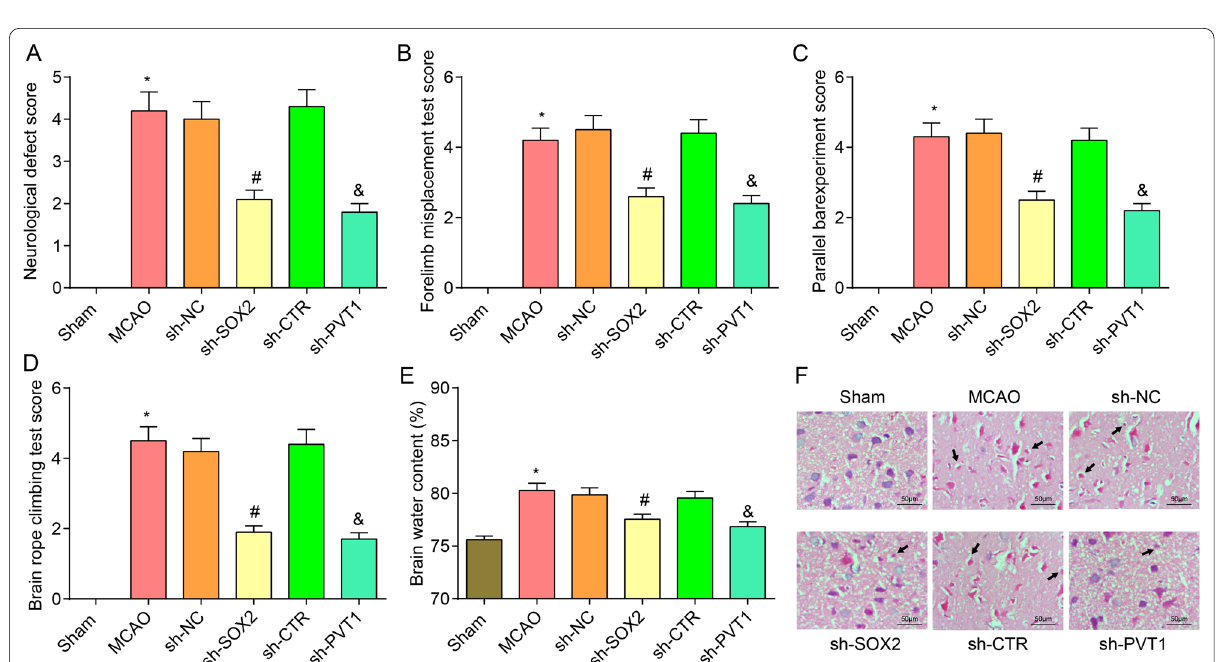
Fig. 3 Depleted SOX2 or PVT1 attenuates neurological deficits, motor behavioral and pathological damage in MCAO rats. A Neurological defect scores of rats in each group after inhibition of SOX2 or PVT1 (n 8 rats per group); B Forelimb foot fault placing test scores of rats in each group = after inhibition of SOX2 or PVT1 (n 5 rats per group); C Parallel bar experiment scores of rats in each group after inhibition of SOX2 or PVT1 = (n 5 rats per group); D Rope climbing test scores of rats in each group after inhibition of SOX2 or PVT1 (n 5 rats per group); E Brain water content = = of rats in each group after inhibition of SOX2 or PVT1 (n 8 rats per group); F HE staining of rat brain injury in each group after inhibition of SOX2 or = PVT1 ( 200; scale bar 50 μm, n 8 rats per group); arrow indicated that the nucleus of neurons appears with pyknosis; * P < 0.05 compared with × = = the sham group; # P < 0.05 compared with the sh-NC group; & P < 0.05 compared with the sh-CTR